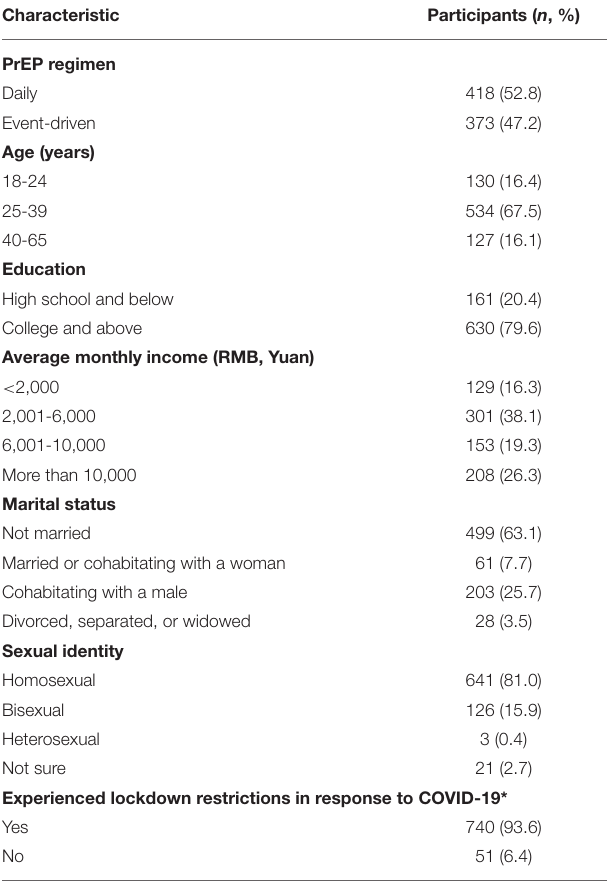
TABLE 1 | Characteristics of Chinese MSM PrEP users during the COVID-19 pandemic ( N = 791).